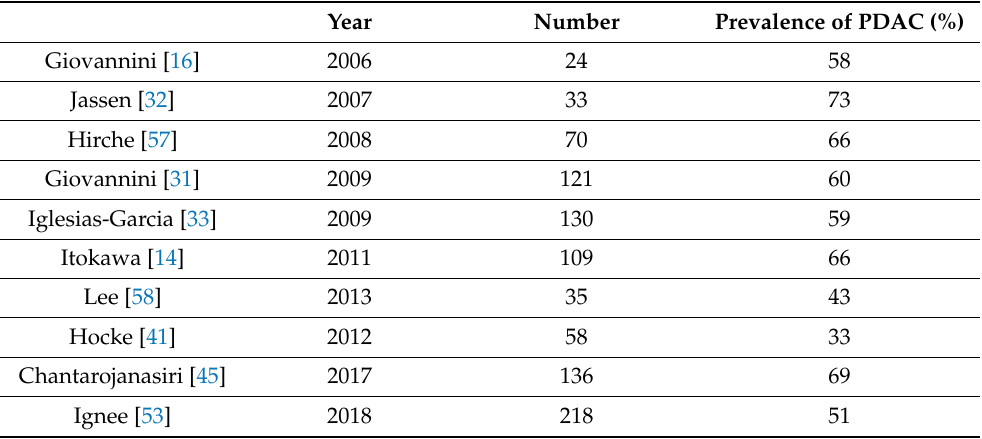
Table 3. Usefulness of color pattern in pancreatic solid